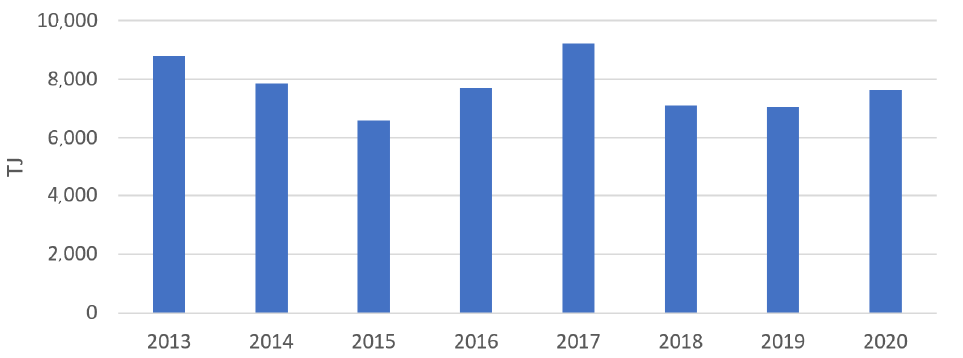
Figure 2. Obtaining energy from water in Poland in 2013–2020 [35].